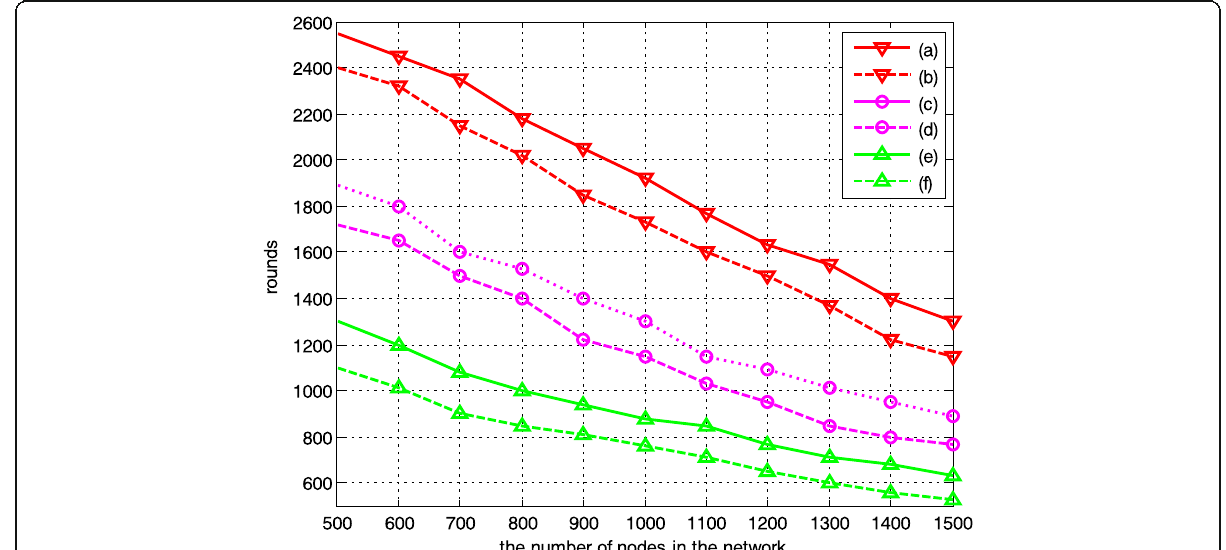
Fig. 7 Comparison of tendency of the network lifecycle changes with the number of